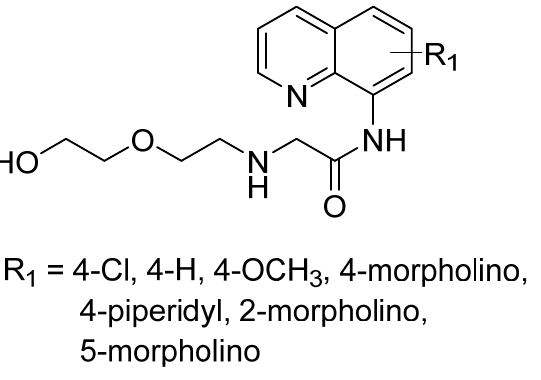
Figure 7. The carboxamidoquinoline-based AQZ family.